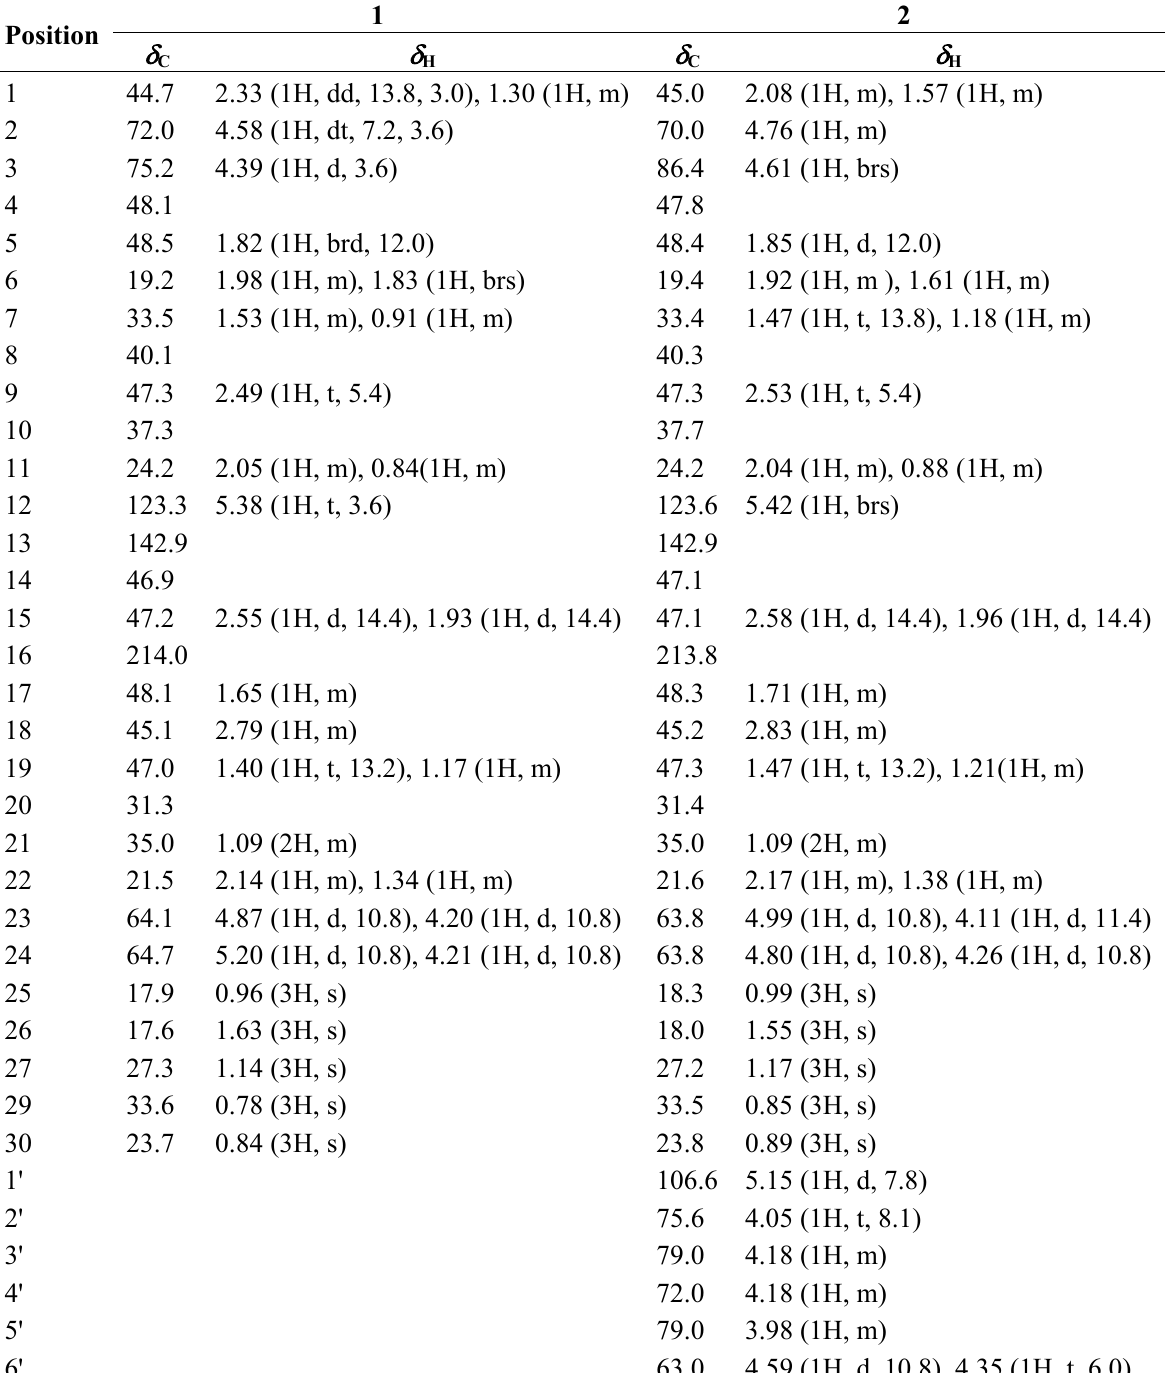
Table 1. 1 H-NMR (600 MHz) and 13 C-NMR (150 MHz) data for compounds 1 and 2 ,  in ppm, J in (pyridine- d 5 H